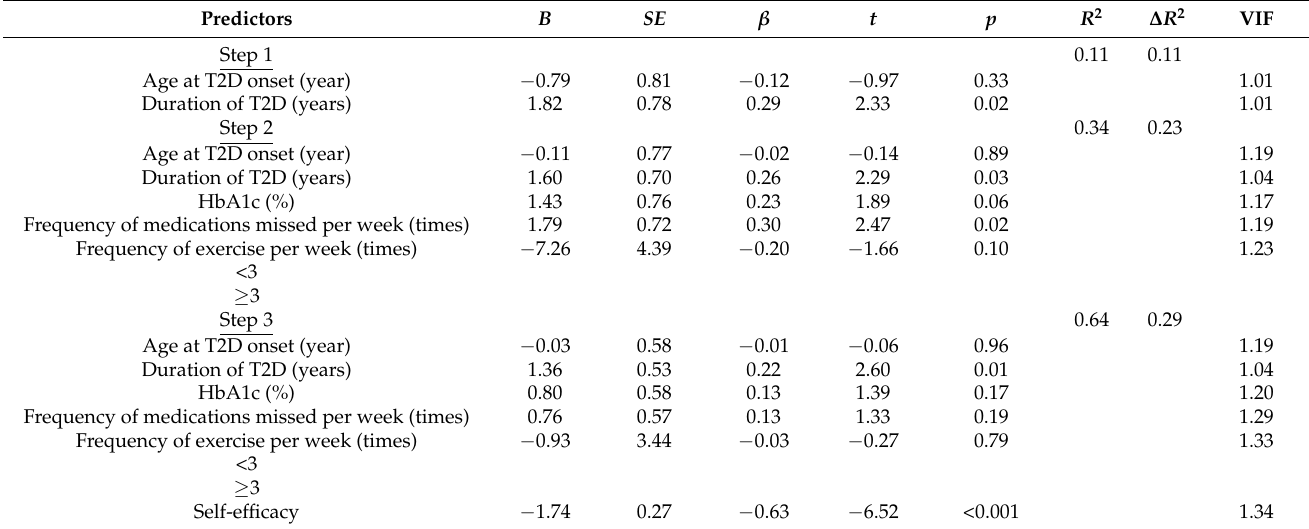
Table 3. Hierarchical multiple regression analysis of predictors for diabetes distress (N =